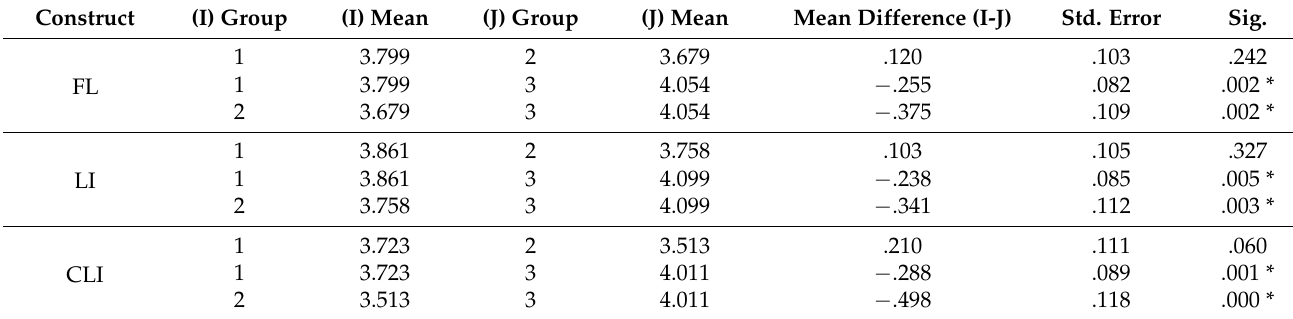
Table 2. Multiple comparisons.